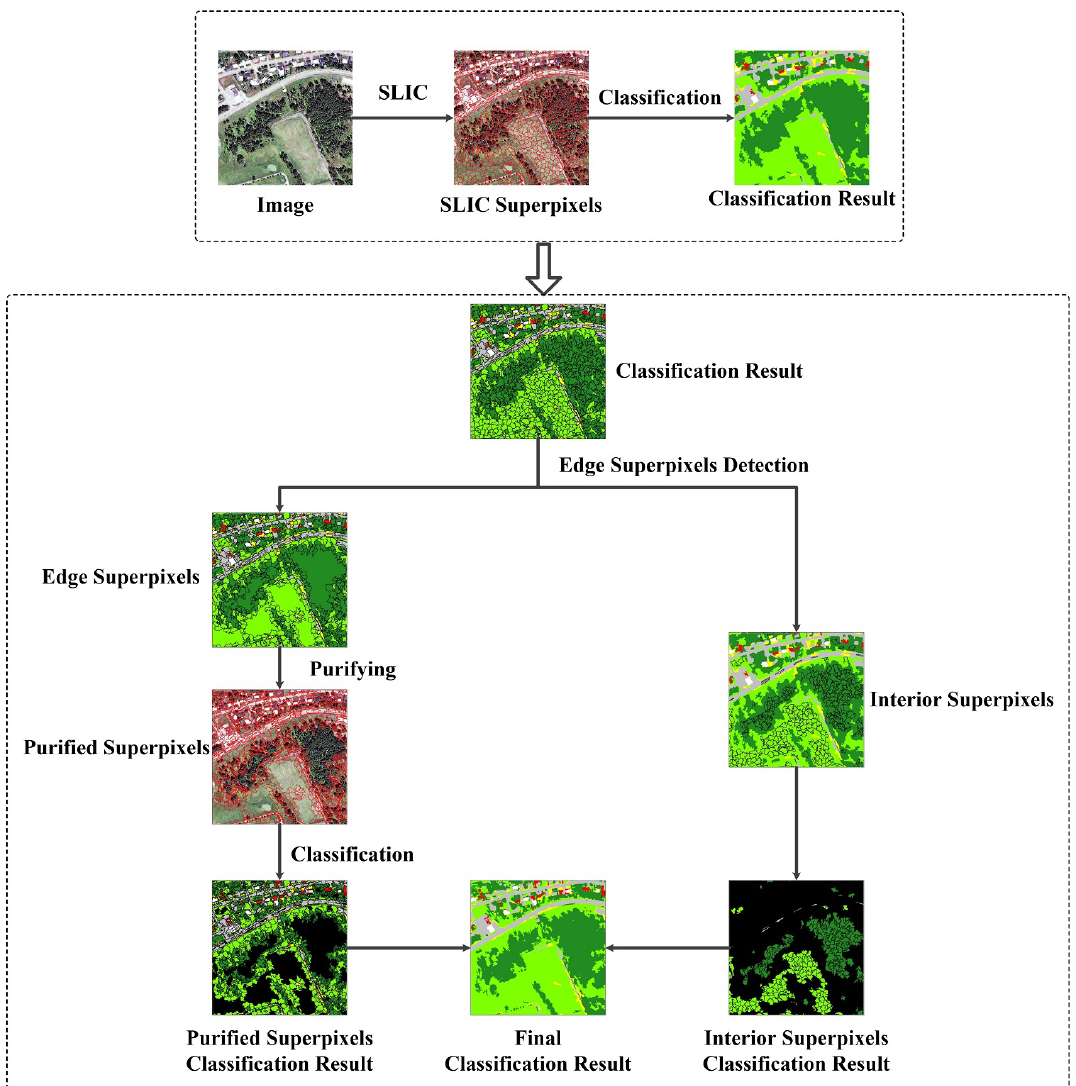
Figure 4. Outline of the proposed Classification